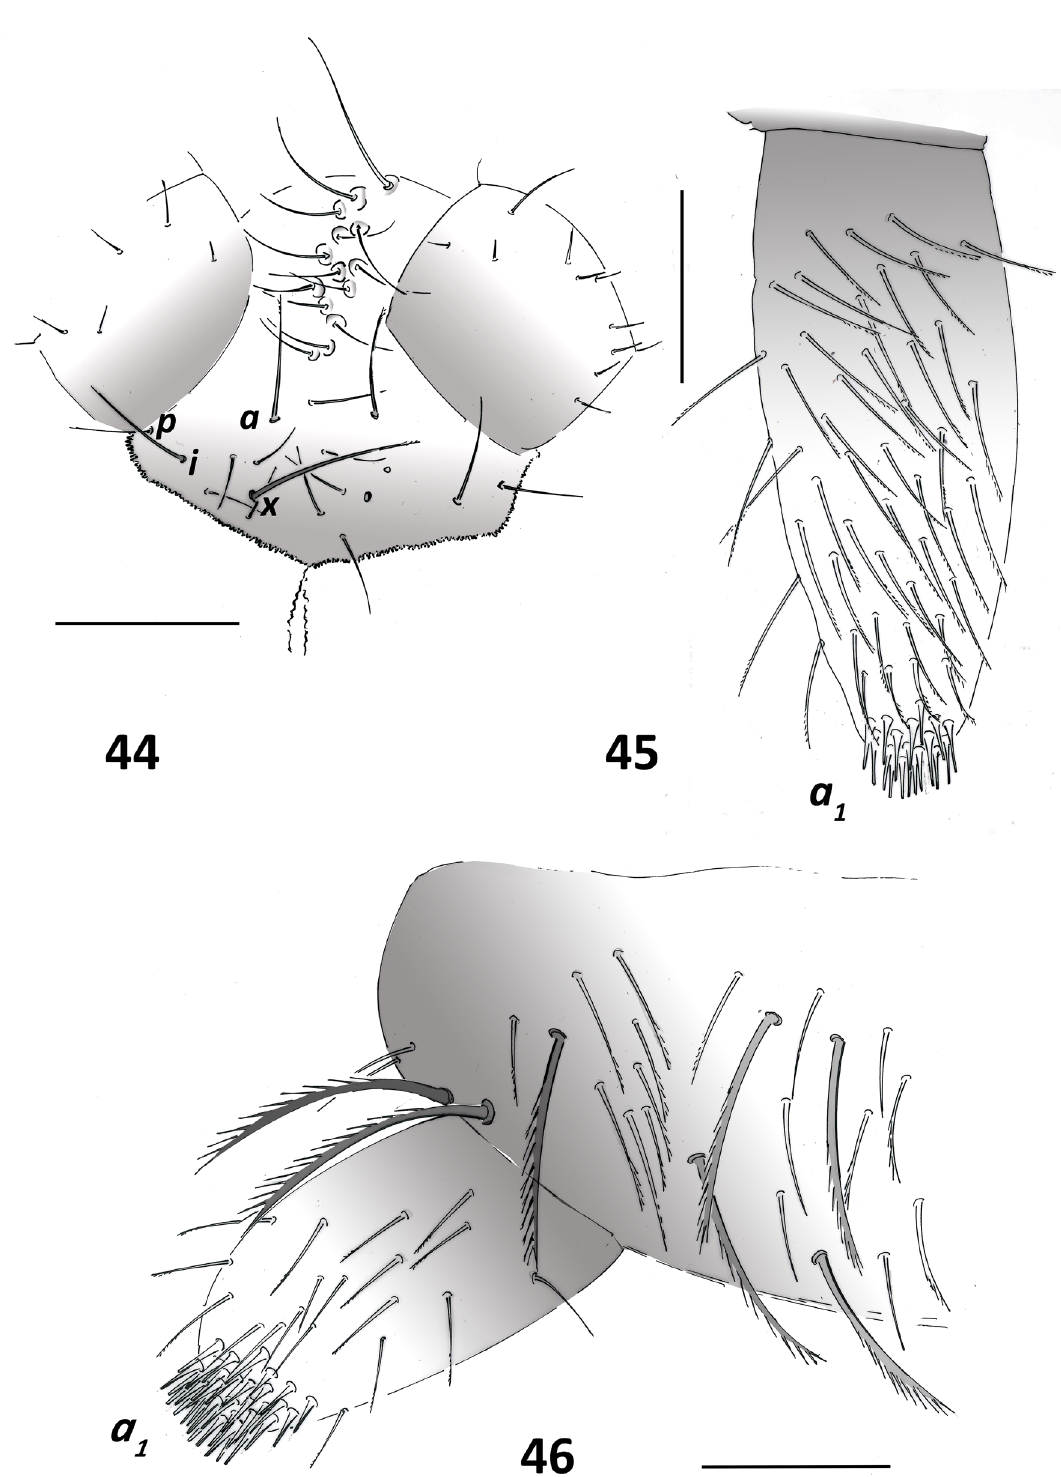
Figs 44–46. Plusiocampa ( Plusiocampa ) chiosensis Sendra & Gasparo sp. nov. 44–45 . Holotype, ♀, 7 mm long, from Spilaio Sykias Cave, Chios Island (MZB 2019-1930). 44 . Frontal process ( a, i and p macrosetae of antennal insertion and x setae). 45 . Right appendage of urosternite I. 46 . Paratype, ♂, 4.9 mm long, from type locality (Coll. AS); urosternite I, right side. Scale bars: 44 = 0.2 mm; 45–46 = 0.1